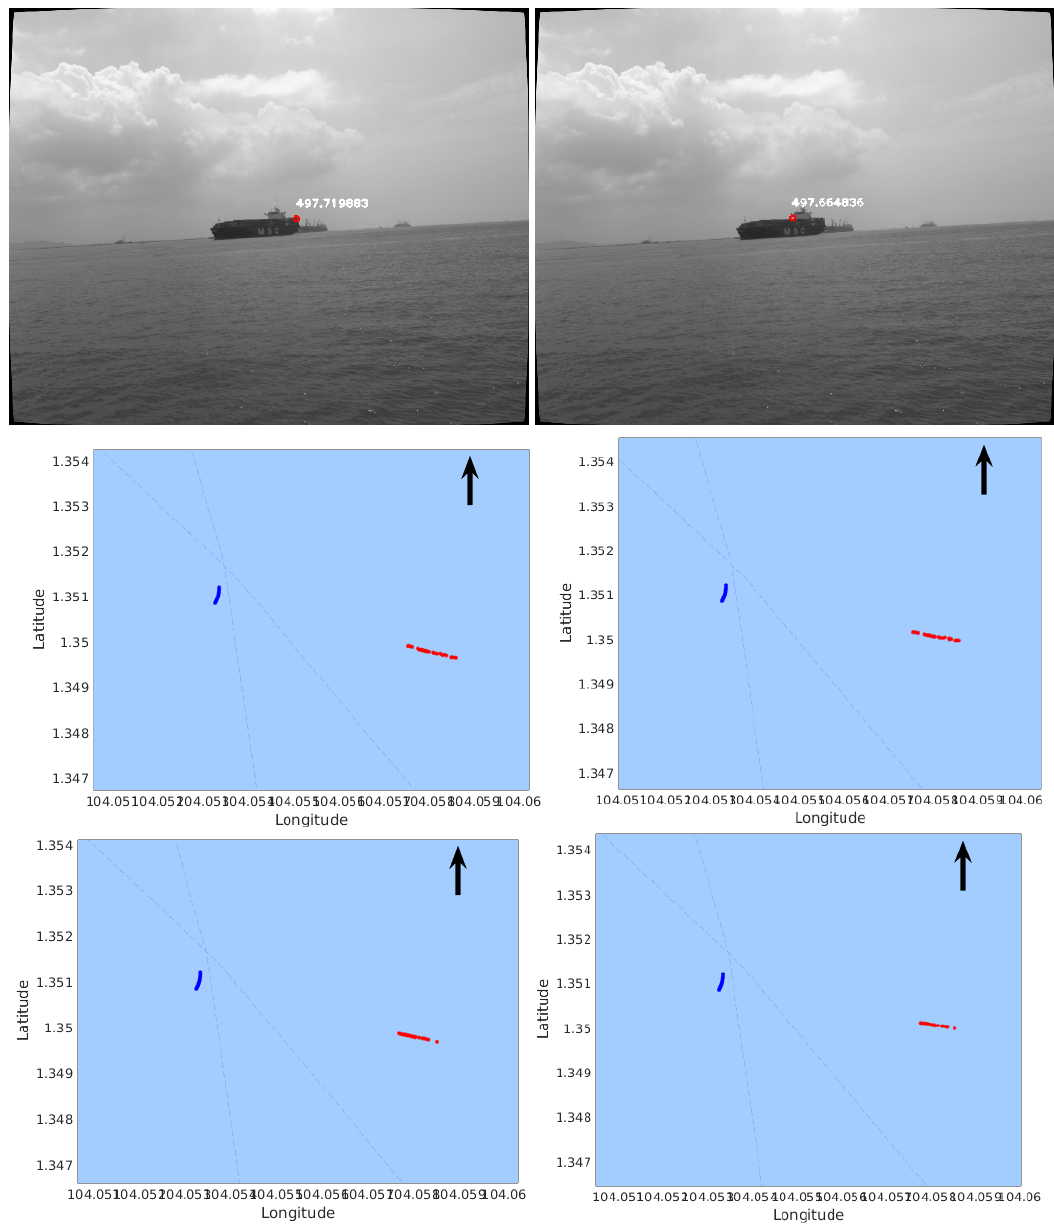
Figure 8. Distribution of mapped feature points (red) in Seq-2. (The blue curve represents the trajectory of our USV; The arrow points to the direction of North.) The left column shows the case of Feature Point #1; the right column shows the case of Feature Point #2. The top row shows the features on images with their distances displayed in meters. The middle row shows the reconstructed points using one pair of frames. The bottom row shows the reconstructed points using ten pairs of